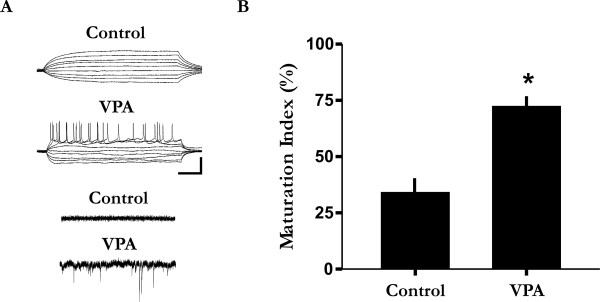
Accelerated development of the TeA network in juvenile animals. A: The majority of cells in treated animals exhibited adult-like electrophysiological properties and spontaneous synaptic activity ("VPA"), and is in stark contrast to that observed in saline or untreated control animals ("control"). The majority of these cells exhibited immature intrinsic neuronal properties similar to that found in new born rats [41]. Voltage responses to a current step protocol were applied from a holding or resting potential of around -60 to -70 mV. In voltage-clamp, cells were clamped at -60 mV. Sale bars: 30 mV vertical and 150 ms horizontal for top two traces; and 15 pA vertical and 400 ms horizontal for bottom two traces. B: Based on the intrinsic membrane properties (see panel A for example), juvenile (< 1 month) VPA-treated animals have a significantly higher maturational index as compared to juvenile control animals. *p < 0.05.